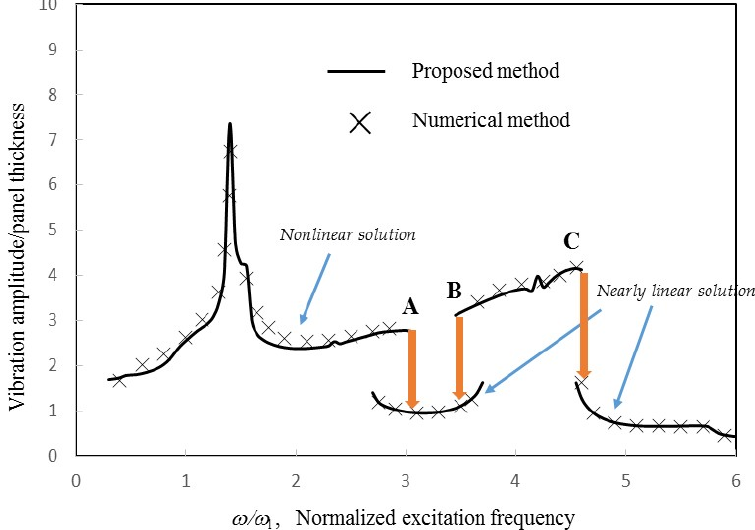
Figure 6. Comparison between the solutions obtained from the proposed method and numerical integration method [6] (number of structural modes = 2, number of acoustic modes = 4, l = 5 a , γ = 4, θ = 0; the orange arrows represent the “jump phenomenon”; “ A ”, “ B ”, and “ C ” represent the particular points on the solution curve).